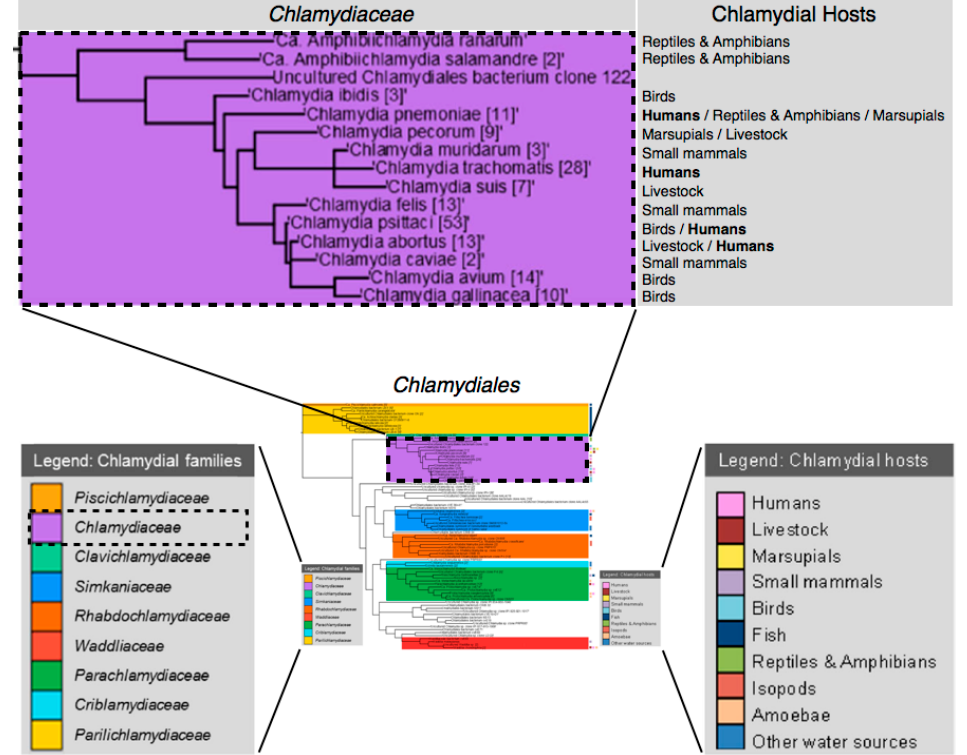
Figure 1. Chlamydiaceae species and hosts. From Chlamydiales phylogenetic tree with contents based on near full-length 16S rRNA gene sequences obtained from Genbank, NCBI. Adapted with permission from [1]. Copyright 2015 Oxford University Press.